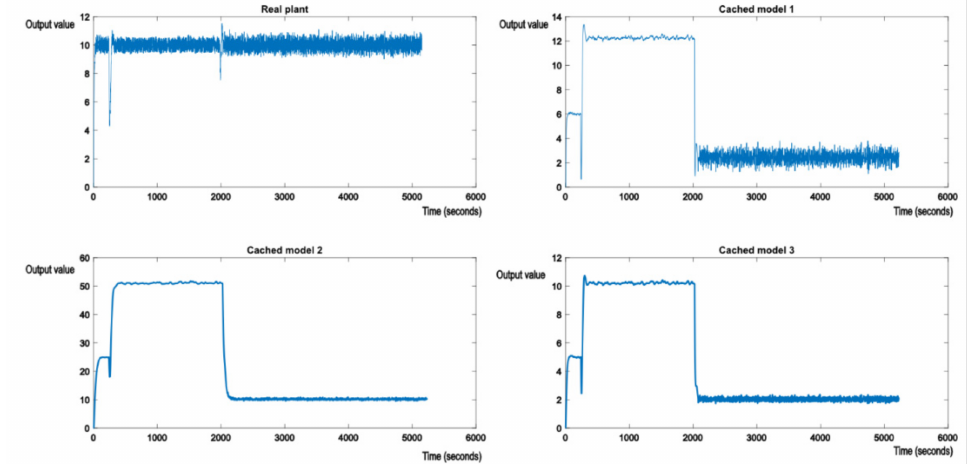
Figure 10. Evolution of the real plant and the nominal models after exposing the real plant to perturbations, switching from model 3 to model 2, with measurement